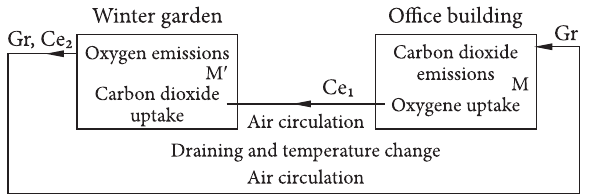
Figure 1. Organization of the ventilation system with the restoration of the gas composition of the air.